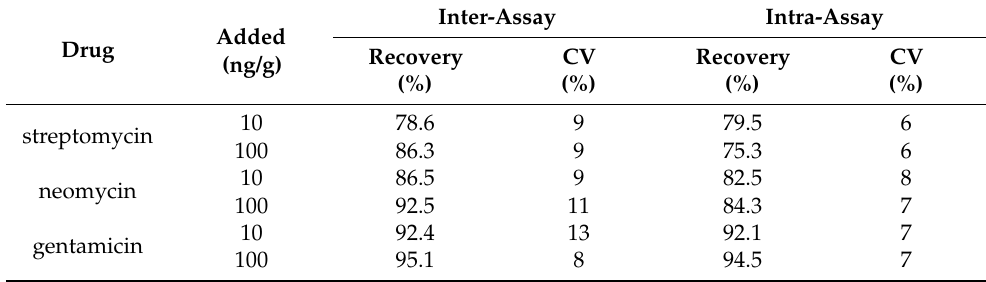
Table 2. AGs recoveries from the standards fortified blank pork muscle samples ( n = 5).